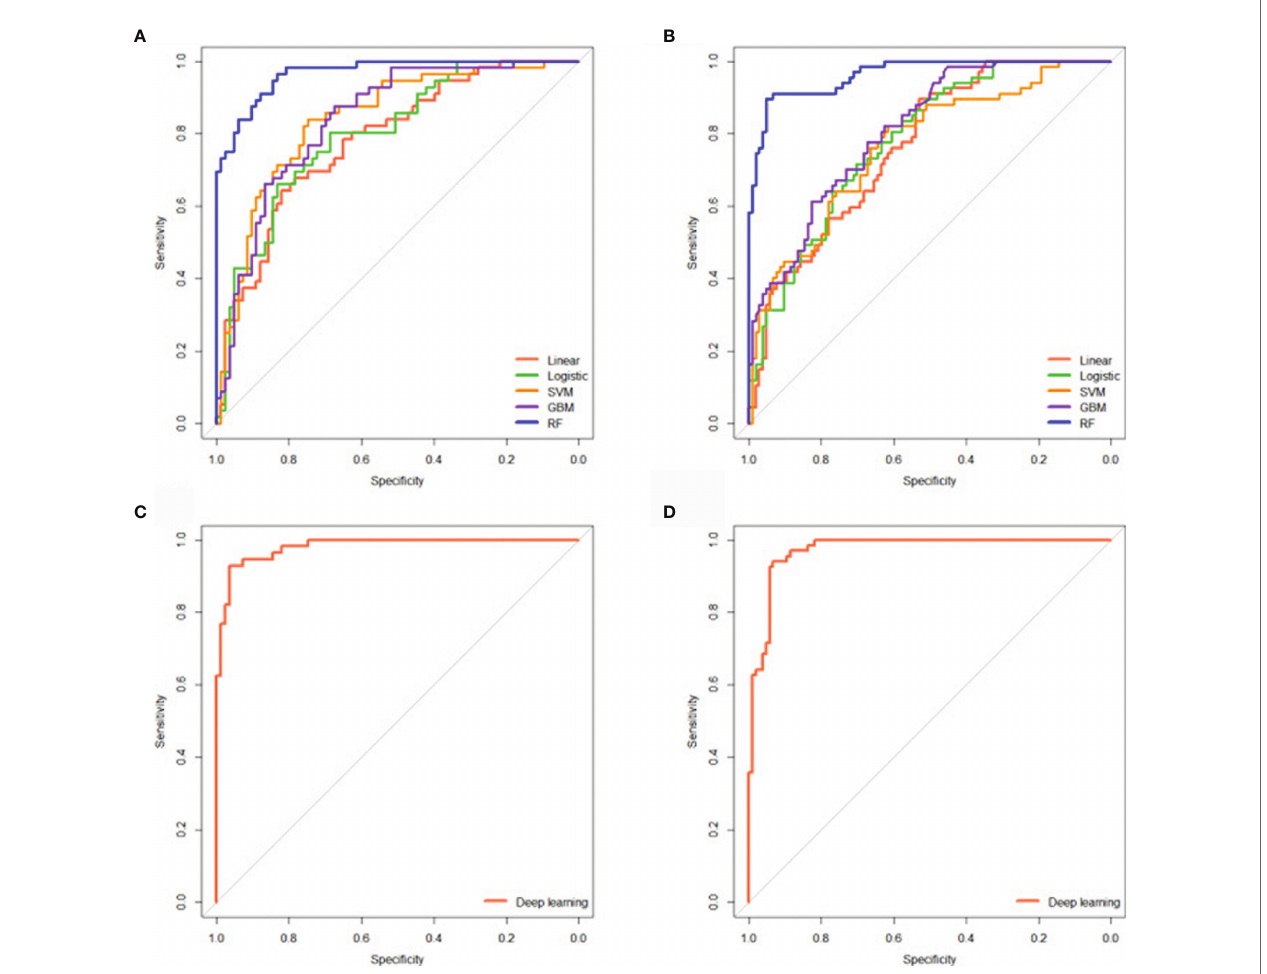
FIGURE 3 | Five radiomics cML models and the DL model could precisely predict initial treatment response to TACE. ROC curves showing the predictive performance of the fi ve cML models for estimating treatment response in the training (A) and validation cohorts (B) . ROC curves showing the predictive performance of the DL model for predicting treatment response in the training (C) and validation (D) cohorts. cML, conventional machine learning; DL, deep learning; ROC, receiver operating characteristic; TACE, transarterial